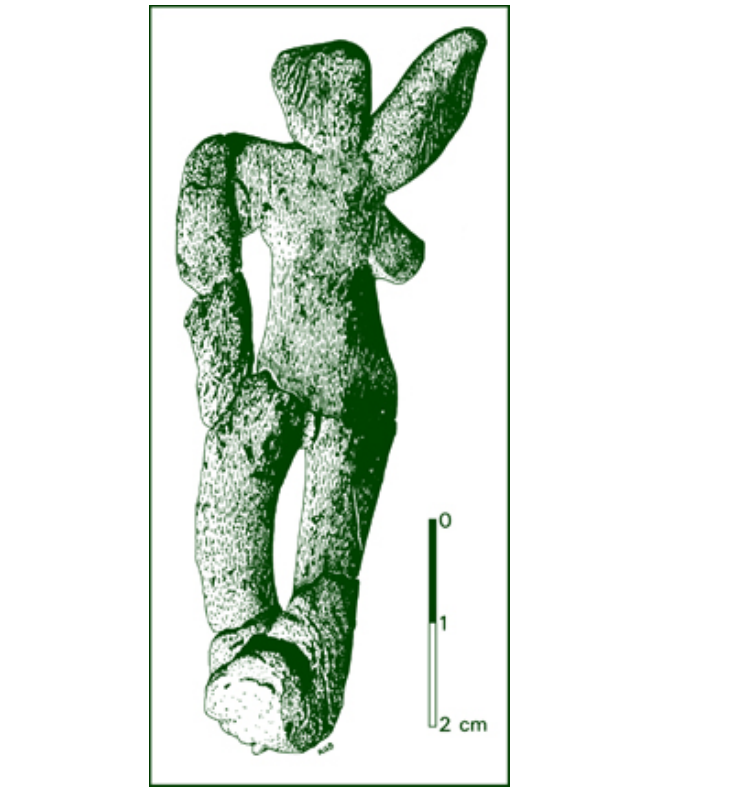
Figure 8. Serpentine figurine of the Aurignacian, ca . 31,790 carbon years old, Galgenberg near Krems,